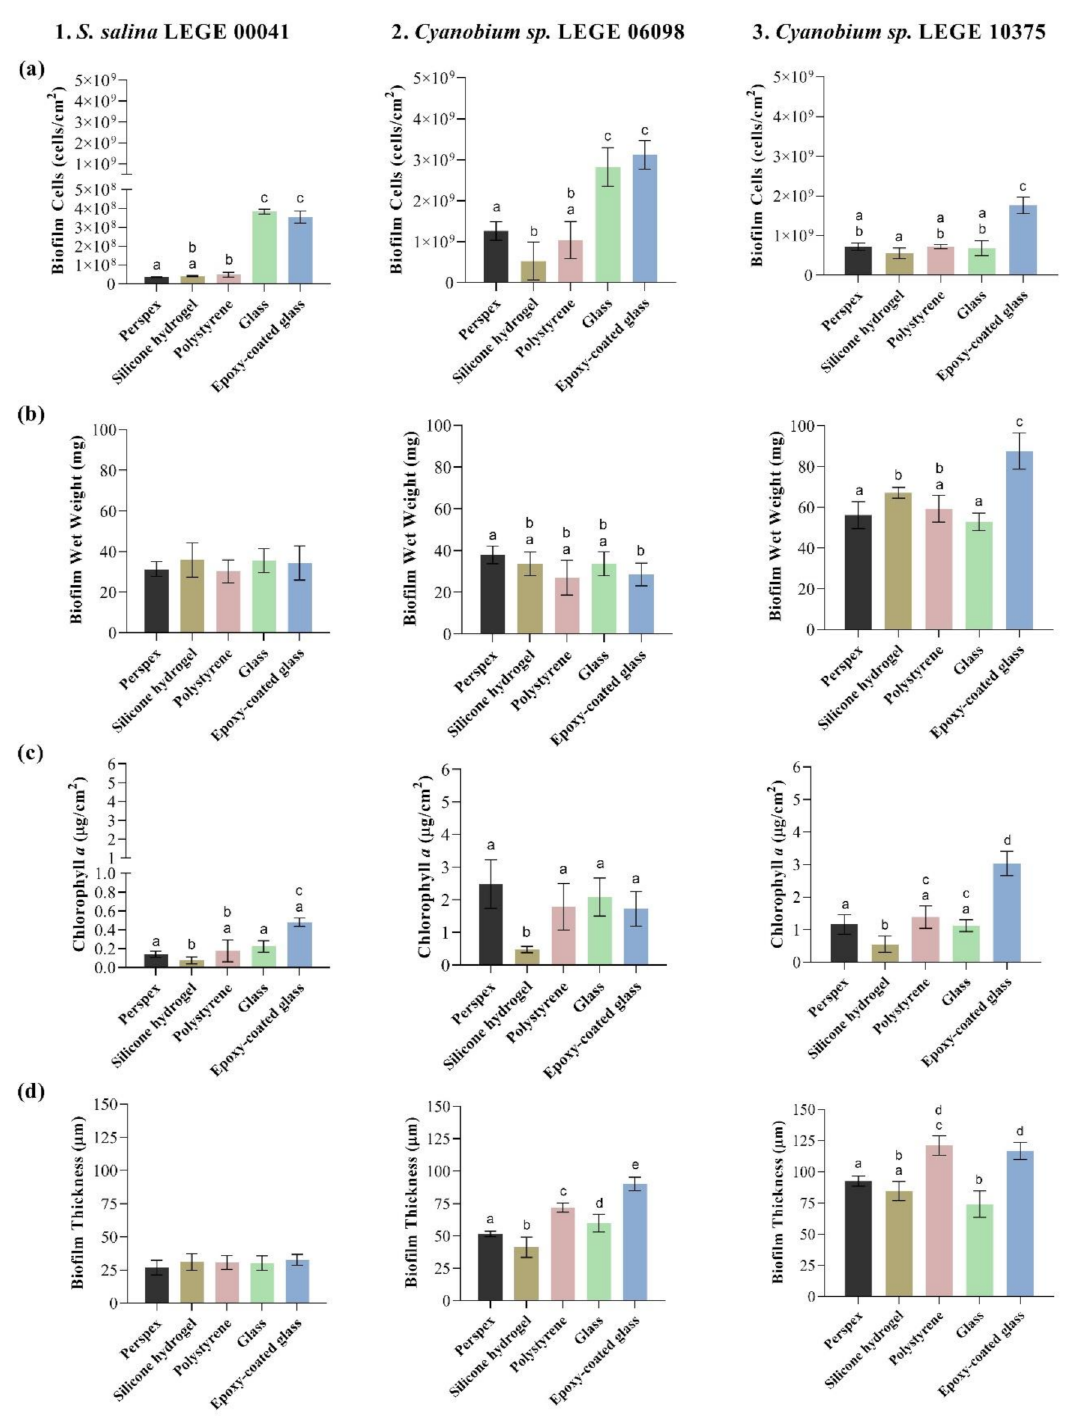
Figure 2. Biofilm development of S. salina LEGE 00041 ( 1 ), Cyanobium sp. LEGE 06098 ( 2 ), and Cyanobium sp. LEGE 10375 ( 3 ) on perspex (cid:4) , silicone hydrogel coating (cid:4) , polystyrene (cid:4) , glass (cid:4) , and epoxy-coated glass (cid:4) surfaces after 49 days. The analyzed parameters refer to the number of biofilm cells ( a ), biofilm wet weight ( b ), chlorophyll a content ( c ), and biofilm thickness ( d ). Error bars indicate the standard error of the mean. For each cyanobacterial isolate, different lowercase letters indicate significant differences between surfaces with a confidence level greater than 95% ( p <